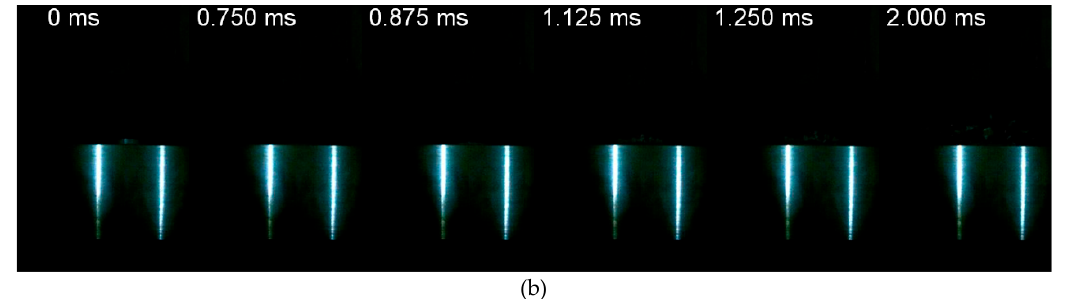
Figure 10. Impact response of HTSed type E reactive material at different drop height: ( a ) h = 120 cm; ( b ) h = 100 cm.